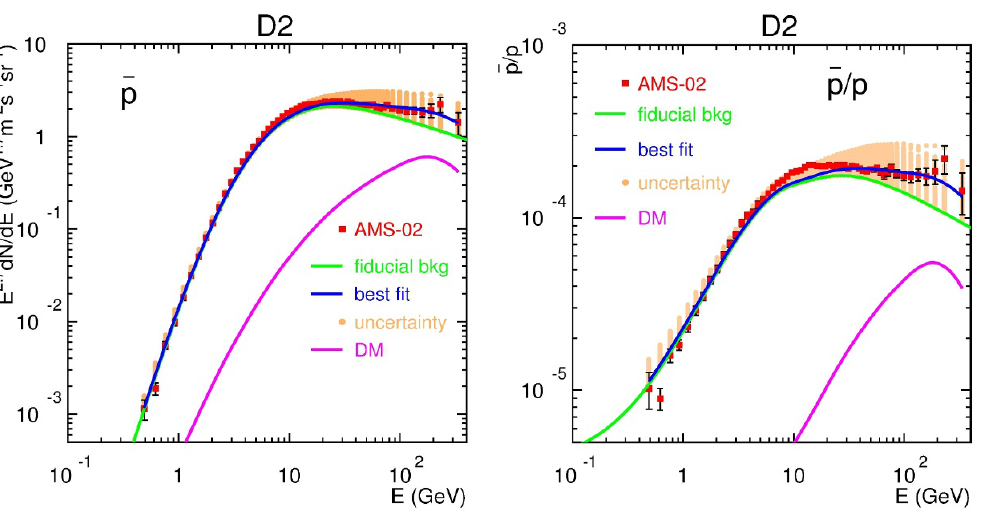
Figure 1 . Antiproton (cid:13)ux (left) and antiproton-to-proton ratio (right) observed by AMS-02 (red dots and dark error bars) in the simpli(cid:12)ed dark matter model D 2 . The blue solid line shows the prediction of the total cosmic ray (cid:13)ux with dark matter parameter values that best (cid:12)t the AMS-02 data. The total predicted (cid:13)ux is the sum of the background (cid:13)ux (green curve) and the dark matter contribution (purple curve). Salmon dots indicate the 2 (cid:27) con(cid:12)dence region of the prediction.